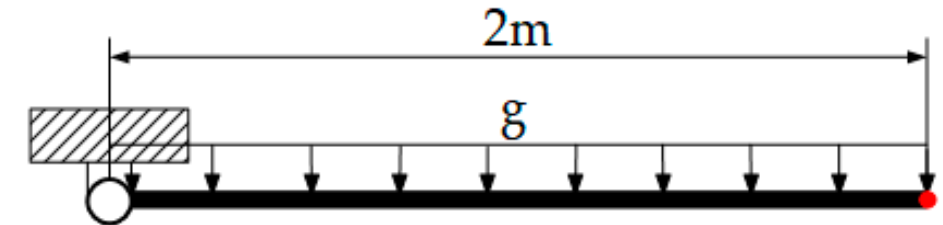
Figure 5. Flexible pendulum model.